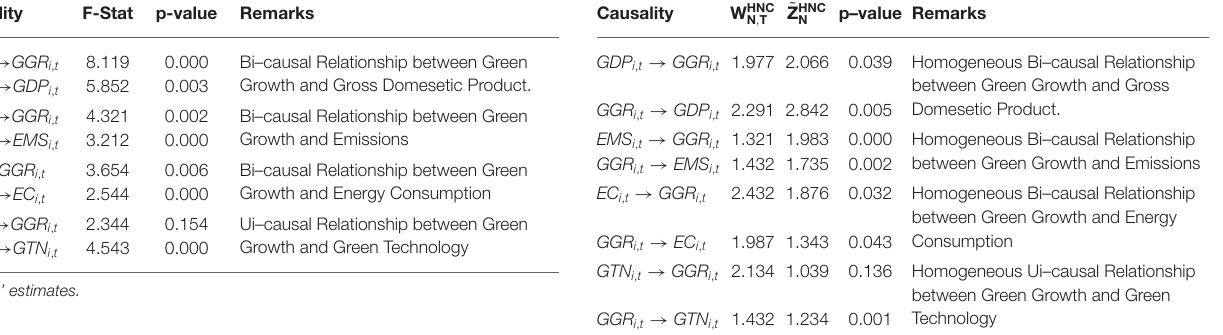
TABLE 10 | Panel granger causality test results. TABLE 11 | Dumitrescu–Hurlin causality test results.